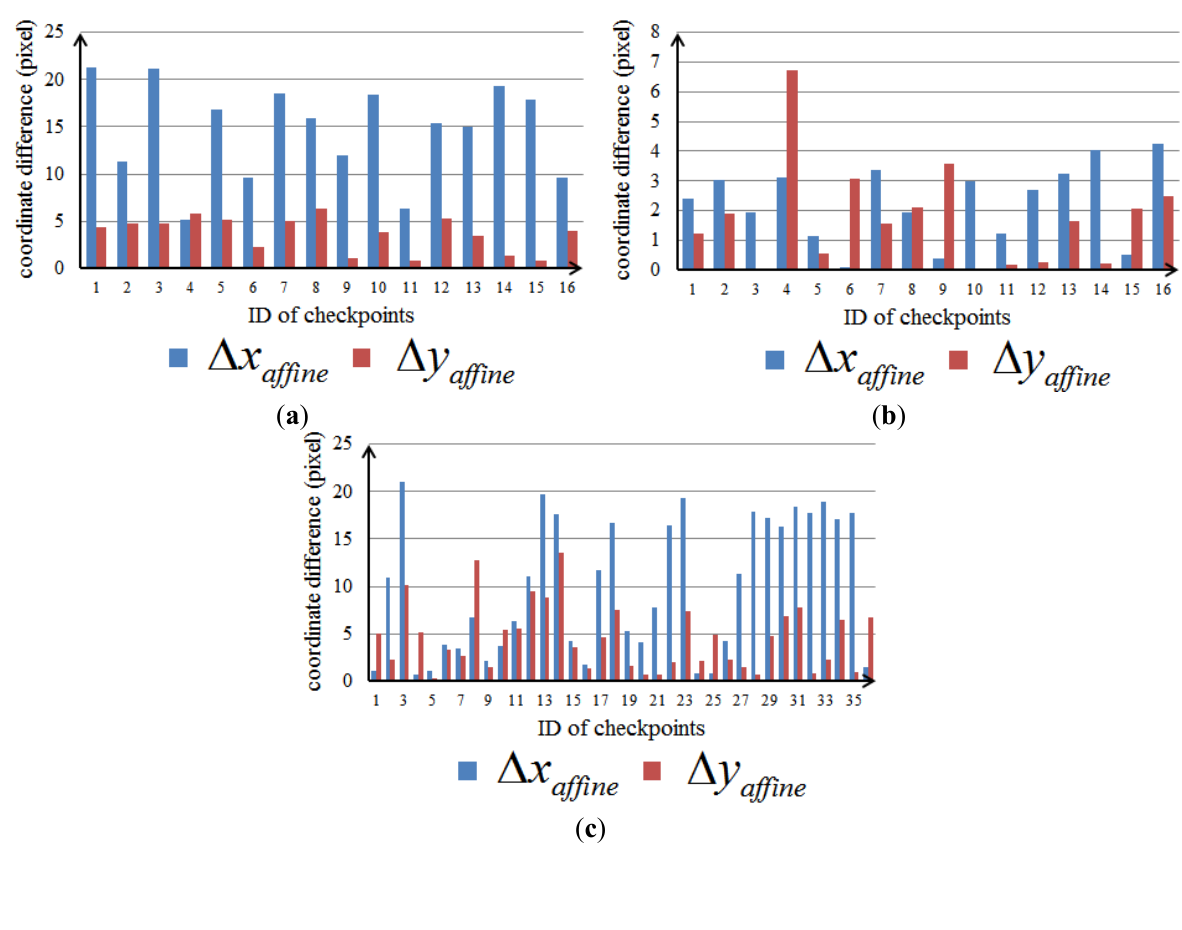
Figure 5. Coordinate differences between estimated and observed values. ( a ) Dataset 1. ( b ) Dataset 2. ( c ) Dataset